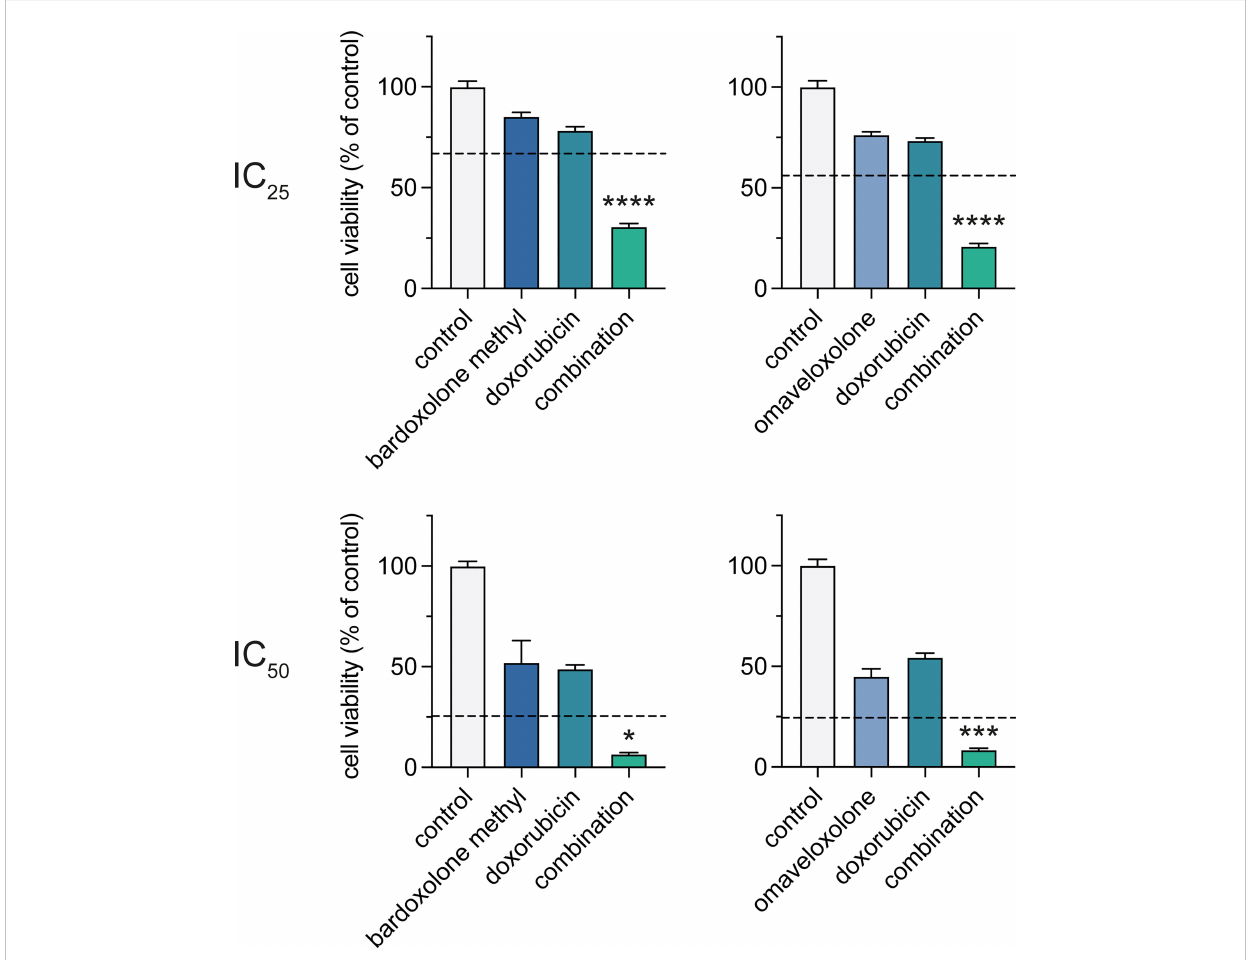
FIGURE 6 Combined treatment with OTs and doxorubicin leads to a synergistic reduction in cell viability of T-ALL cells. Cell viability of MOLT-4 cells after treatment with